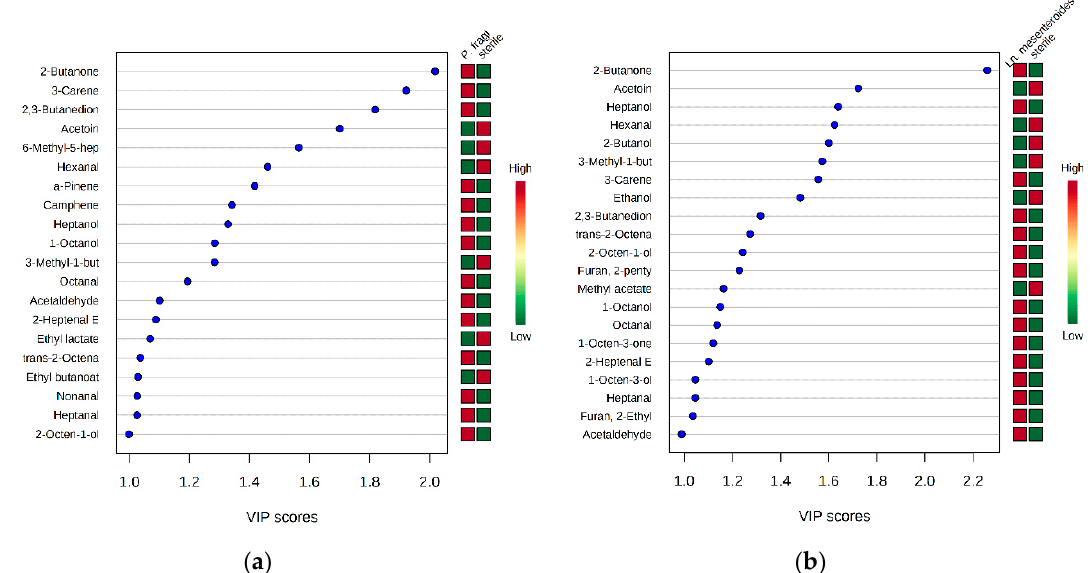
Figure 2 . Important features identified by partial least squares-discriminant analysis (PLS-DA) for sterile meat and meat inoculated with: ( a ) P. fragi (monoculture) and ( b ) Ln. mesenteroides (monoculture) stored at 4 and 10 °C. The color scale on the right represents the scaled abundance of each variable, with red color boxes indicating high abundance and green color boxes indicating low abundance.